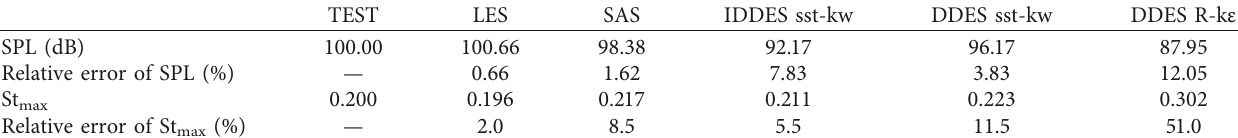
Table 1: SPL and peak Strouhal number of the five models at 128d far-right position over the cylinder.